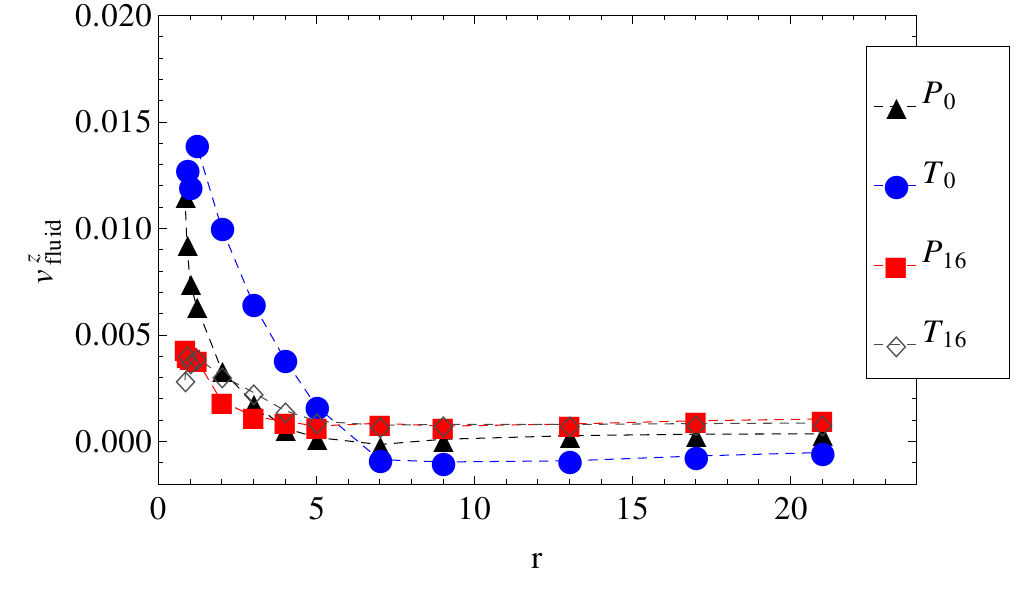
Figure 3. The axial component of the fluid velocity around the polyion as a function of radial distance r , for N = 180 . The legend notation is the same as in Figure